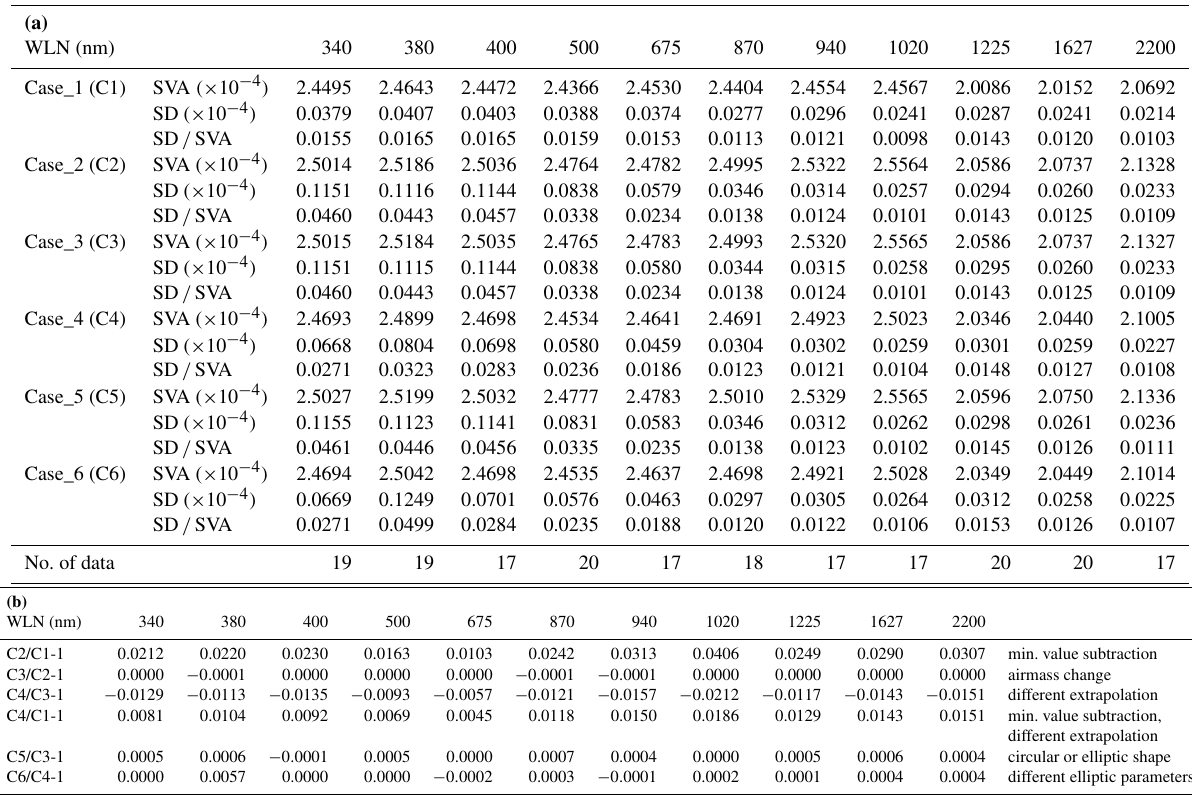
Table 2. Influence of the different calculation settings. (a) Calculated SVA. The data taken at MLO in October and November 2015 are used. (b) Comparison of calculated